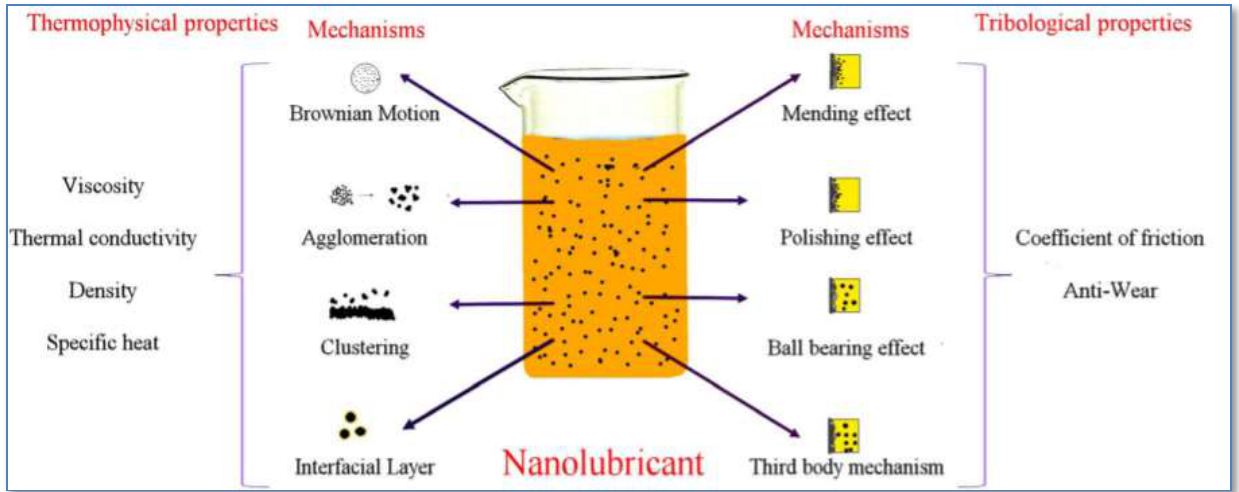
Figure 1: Graphical performance of various mechanisms involved with nano-lubricant [47].